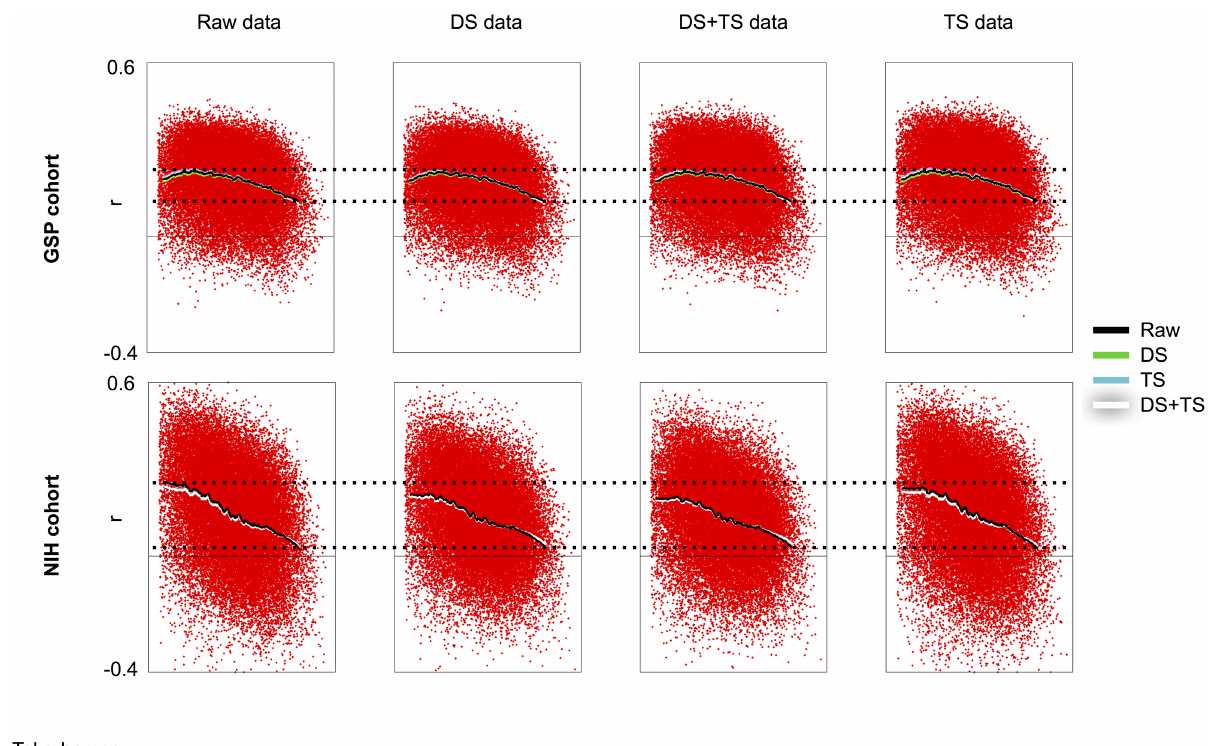
Fig 6. QC:RSFC correlations are not systematically changed across processing strategies. For the GSP and NIH cohorts, QC:RSFC analysesusing variousFD traces in data from variousstages of processingare shown. There is no systematic influenceof processingin these cohorts or in the other cohorts (shown in S7 Fig). The x-axis representsdistance, spanning0–180